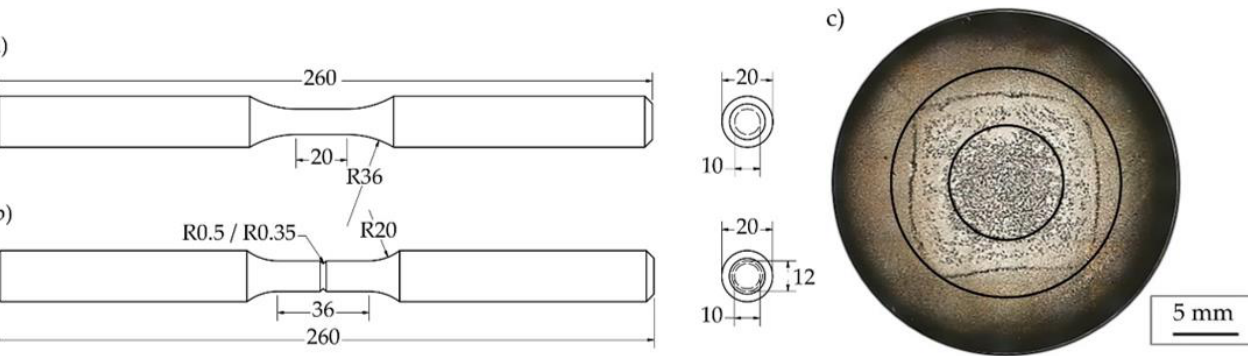
Figure 1. ( a ) Unnotched specimen’s geometry, ( b ) Notched specimen’s geometry and ( c ) Light microscopic image of the material as delivered.